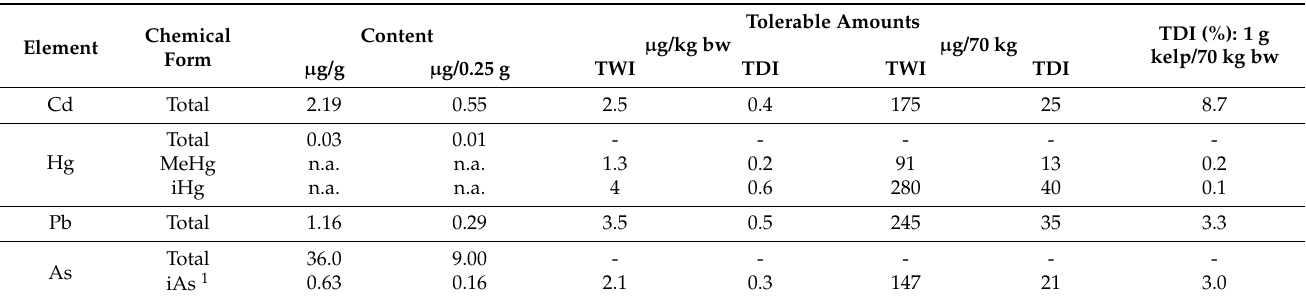
Table 3. The content of arsenic, cadmium, lead, and mercury in 0.25 and 1 g of boiled, dried S. latissima and the tolerable amounts of the PTEs. The tolerable daily and weekly intakes (TDI, TWI) for the PTEs are provided by EFSA [35–38].